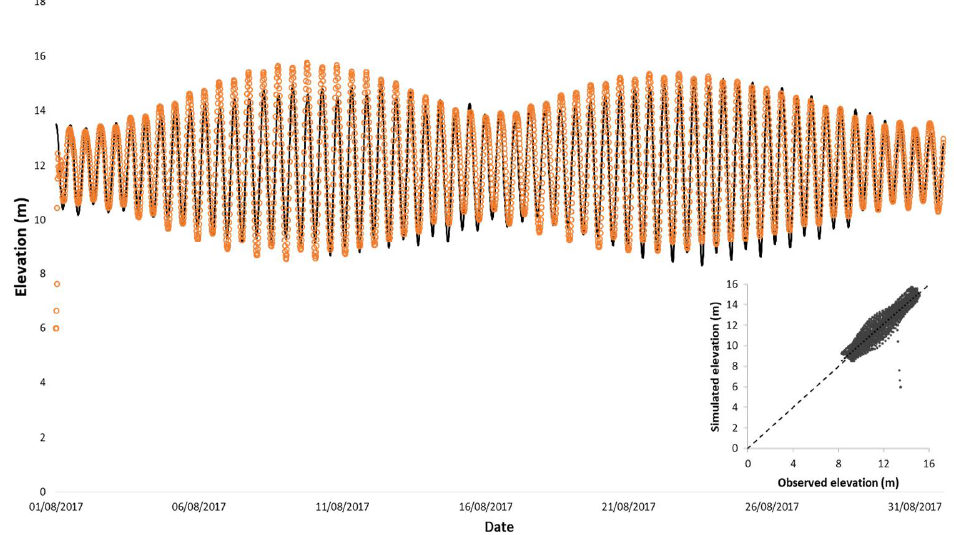
Figure 3. Observed (line) and simulated (points) free surface elevations at Immingham after calibra- tion for a representative summer month (August 2017). Inset: Point correlation between observed and simulated tidal elevations (R2 = 0.883).